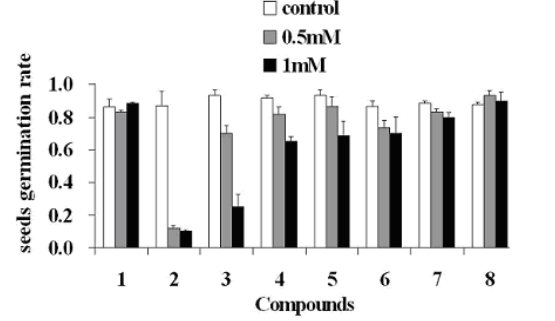
Figure 4. Arabidopsis seed germination rates recorded after three days in Hoagland medium containing one of the isolated compounds 1 - 8 at the indicated concentrations or nothing (control: filter paper treated with 3 mL of pure acetone). Bars indicate maximal deviations from mean values derived from three independent measurements. Seeds germination rate ＝ (number of germinated seeds/30) ×